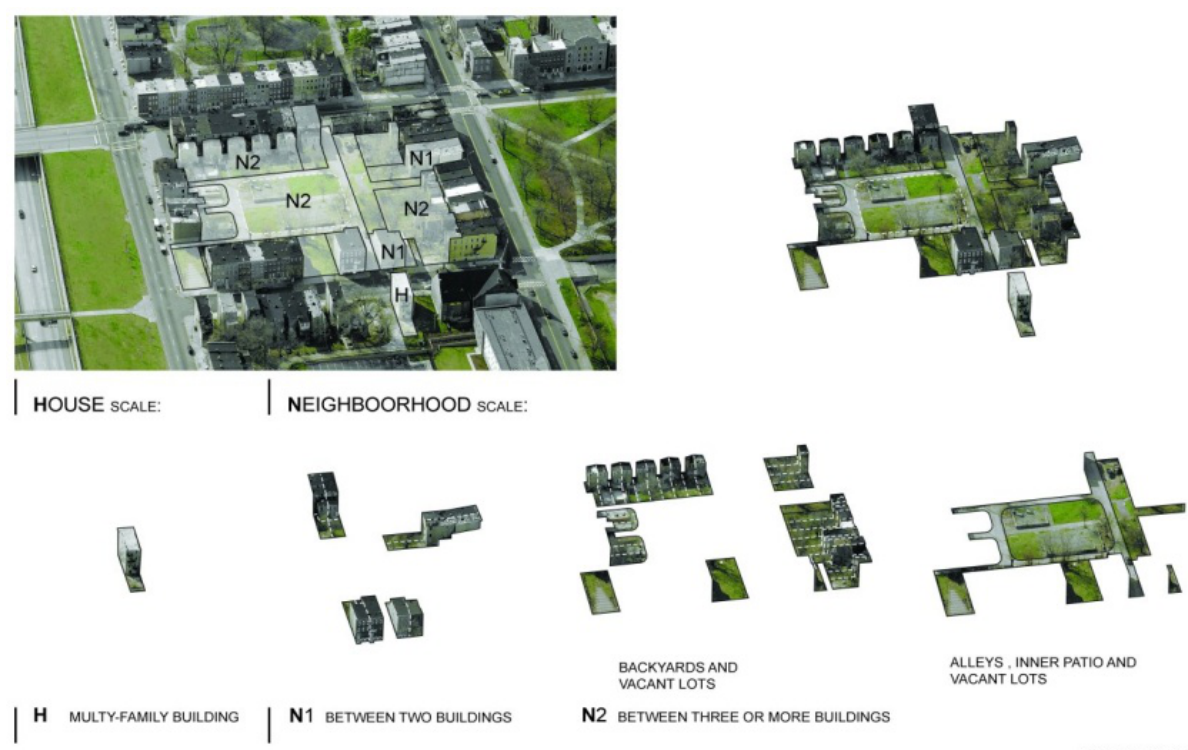
management strategies: street side tree belts, alleyways, vacant lots, community gardens and green roofs. The inner block alley houses were demolished to make way for back-yard parks in the 1950s. (Courtesy of